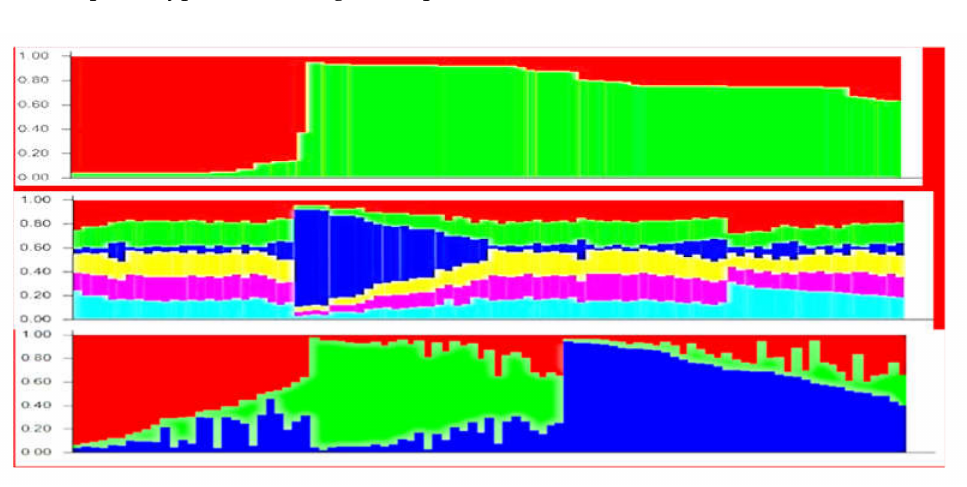
Figure 1. Genetic structure among 95 chrysanthemum accessions based on SSR ( top ) (K = 2), SCoT ( middle ) (K = 6), and ISSR ( bottom ) (K = 3) data, respectively. Each segment represents the estimated membership fraction of each genetic